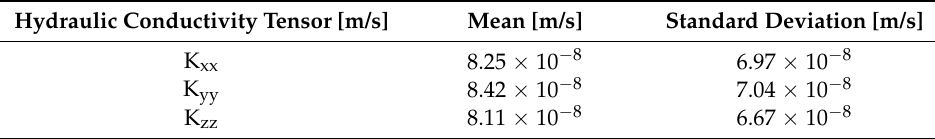
Figure 9. DFN transmissivity distribution for granite and sedimentary rock regions. Table 3. Upscaled hydraulic